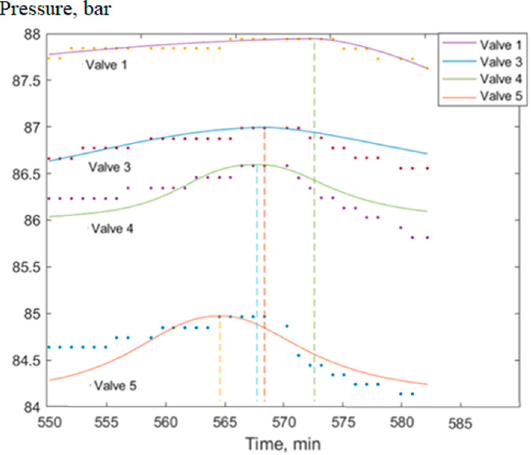
Figure 4. Approximation of curves p i ( t ) (valves 1, 3, 4, and 5). Compression waves. Example 2.